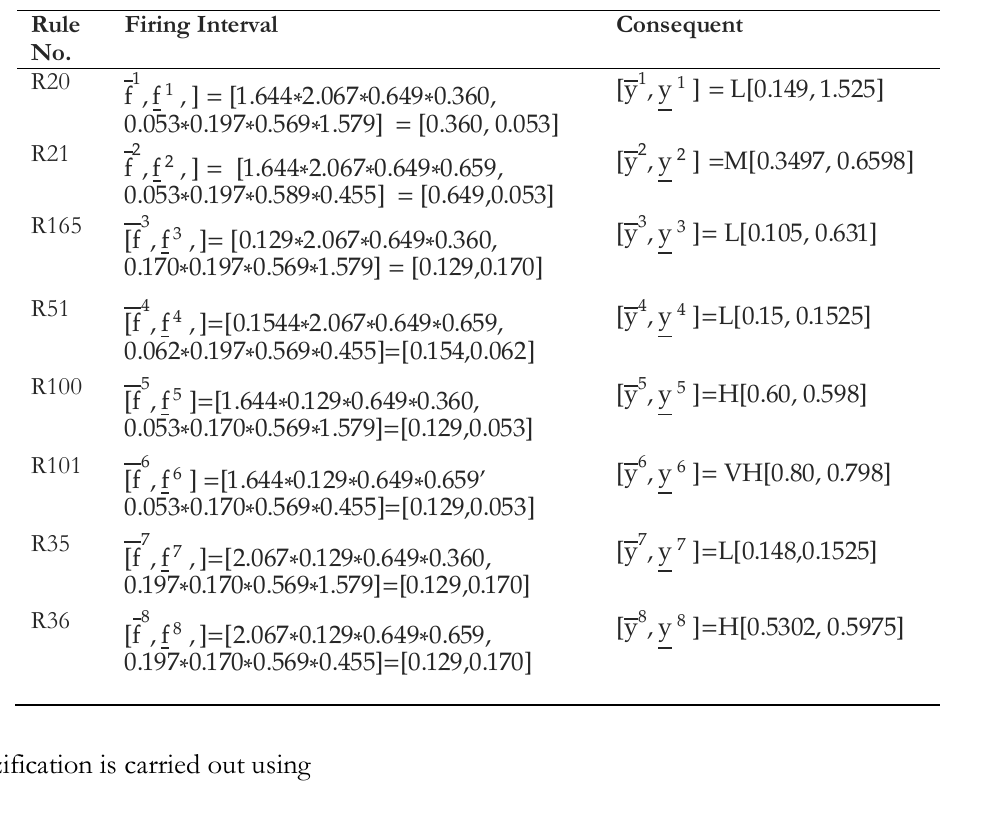
Table 4. The firing